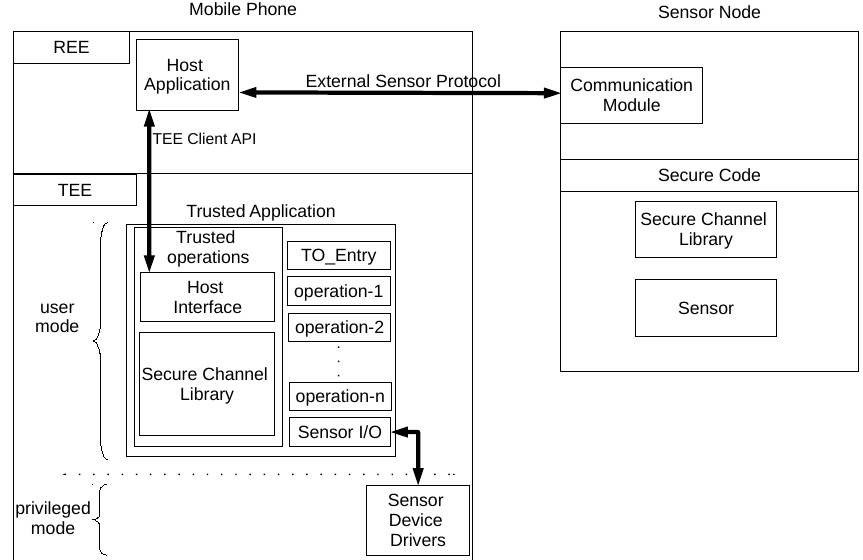
Figure 3. Trusted operations